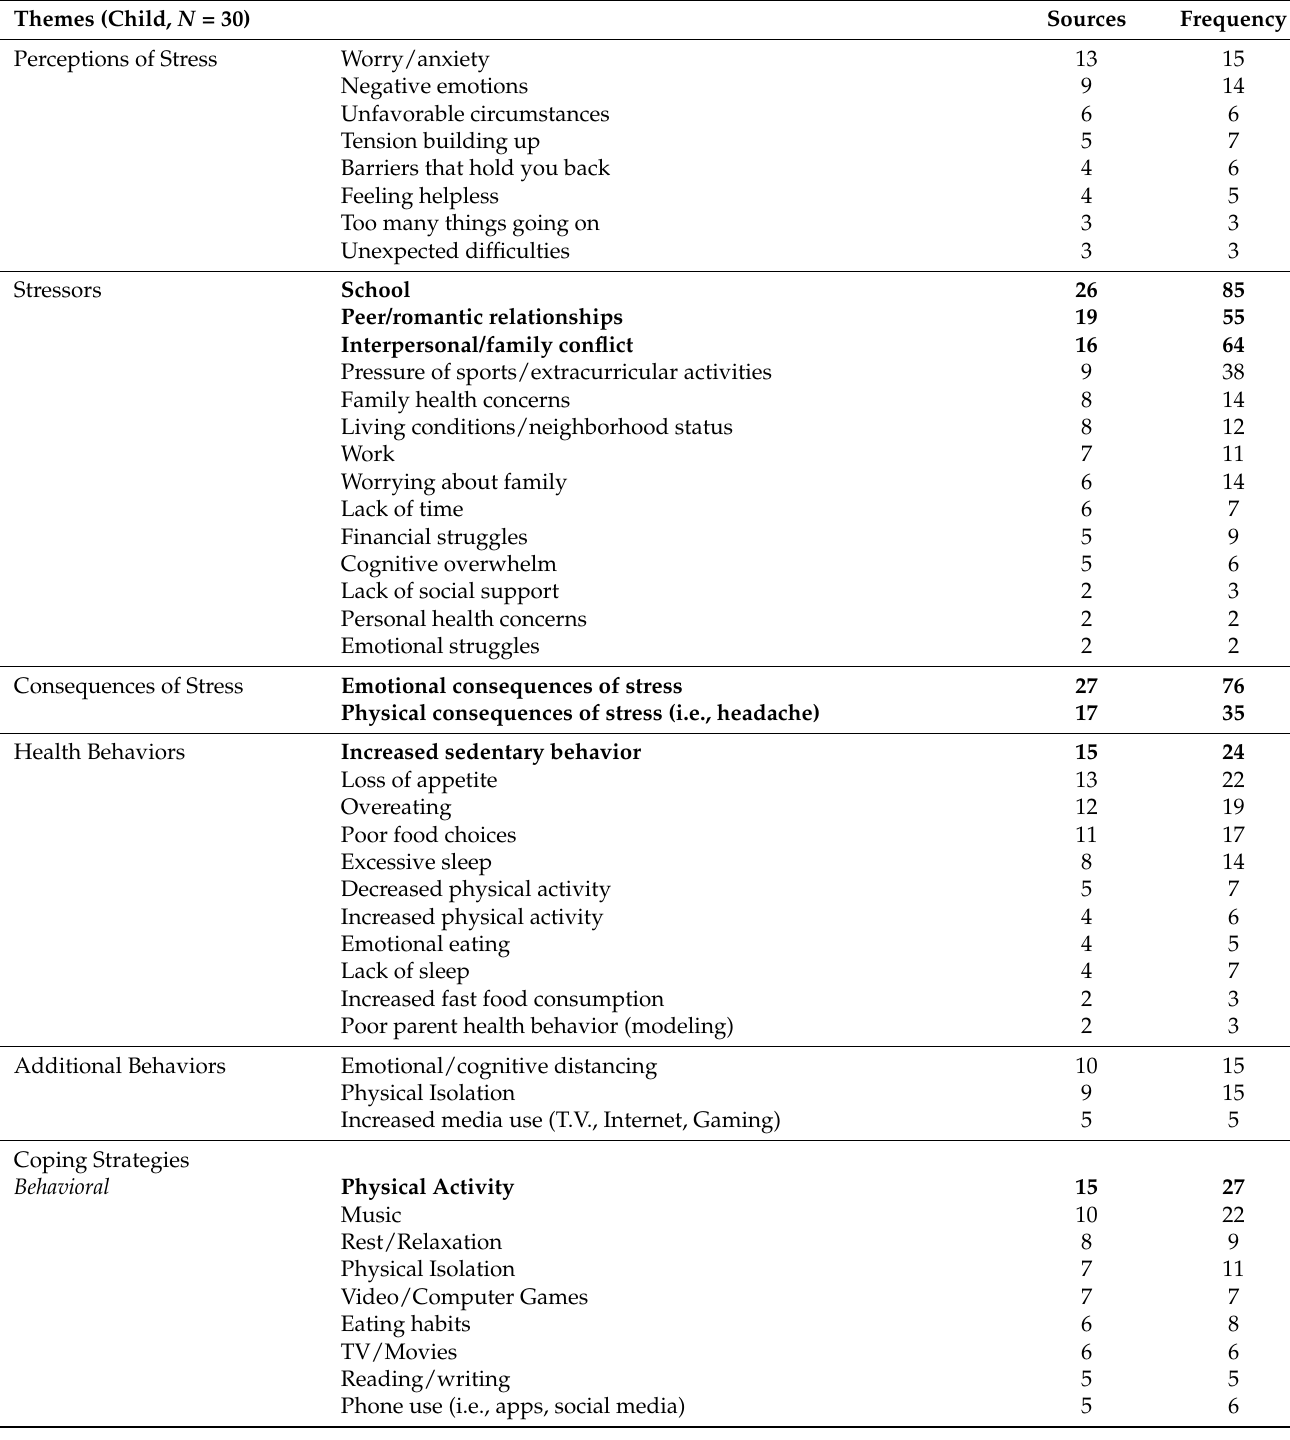
Table 3. Summary of